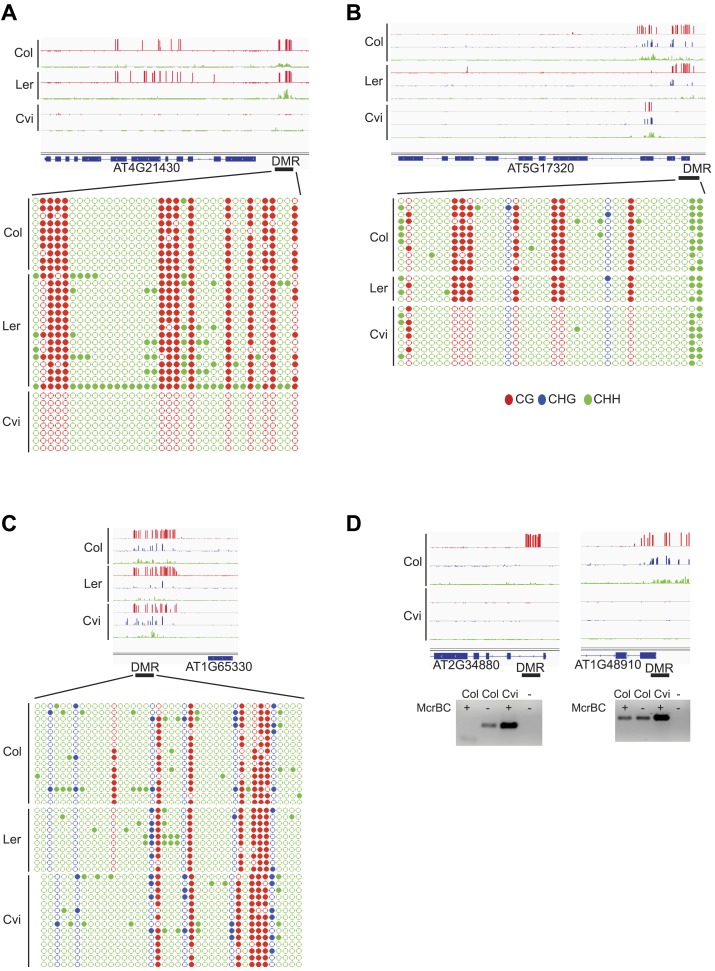
Validation of BS-seq results with locus-specific BS-PCR or McrBC-PCR.(A) AT4G21430. (B) AT5G17320. (C) AT1G65330. Top: CG, CHG and CHH methylation profiles of Col, Ler, and Cvi embryos and strain DMRs selected for validation. Bottom: methylation of individual sequenced clones from locus-specific BS-PCR. Filled circles indicate methylation, whereas unmethylated positions remain unfilled. (D) McrBC digestion of leaf genomic DNA followed by PCR of AT2G34880 and AT1G48910.